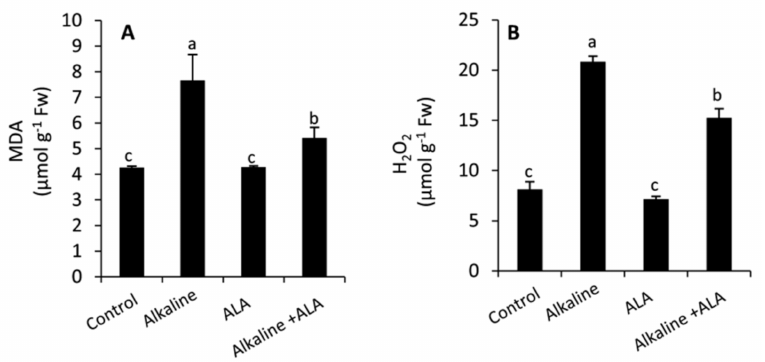
Figure 3. Effect of exogenous α -lipoic acid (ALA; 20 µ M) on the concentration of malondialdehyde; MDA ( A ) and H 2 O 2 ( B ) in the leaves of wheat seedlings grown under sodic alkaline stress.